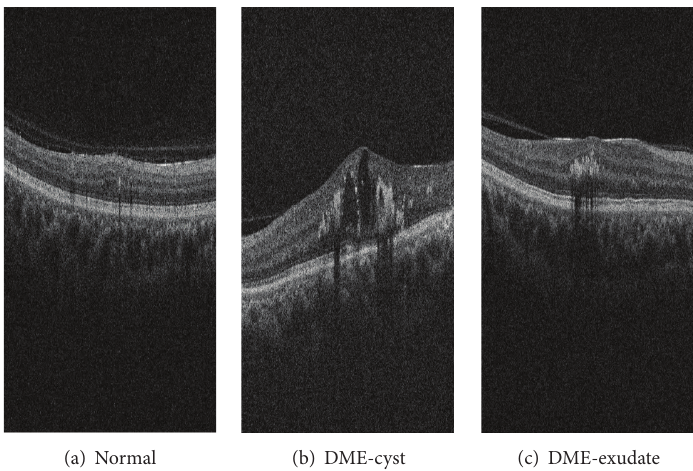
Figure 1: Example of SD-OCT images for normal (a) and DME patients (b)-(c) with cyst and exudate,